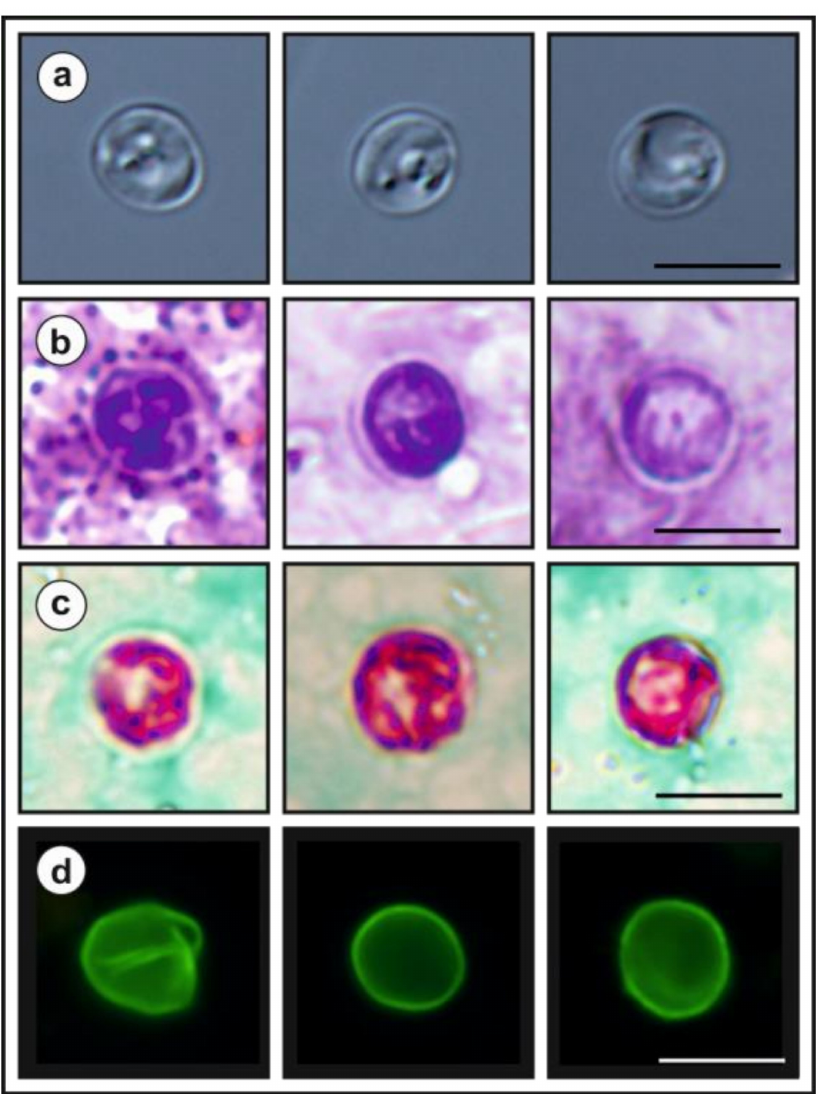
Figure 9. Oocysts of Cryptosporidium myocastoris n. sp. ( a ) in differential interference contrast microscopy, ( b ) stained by aniline–carbol–methyl violet staining, ( c ) stained by Ziehl–Nielsen staining, and ( d ) labelled with anti- Cryptosporidium FITC-conjugated antibody. Bar = 5 µ